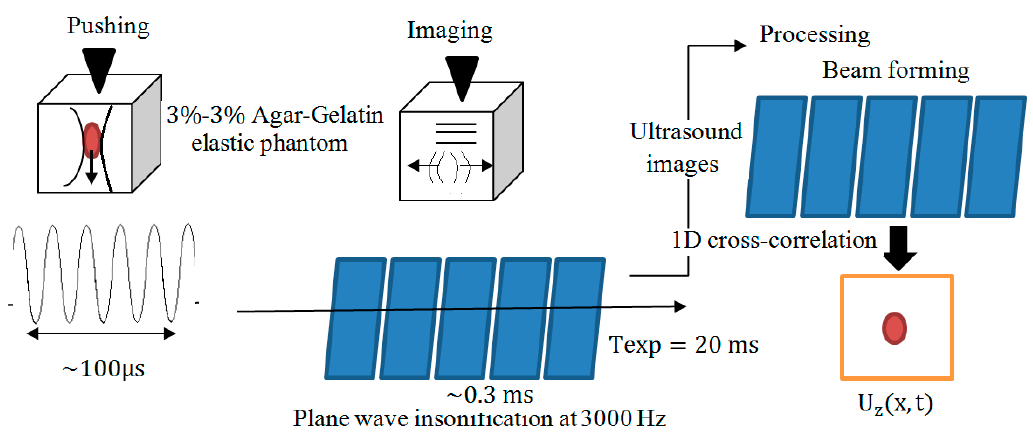
Figure 2. Schematic drawing of supersonic shear imaging (SSI).